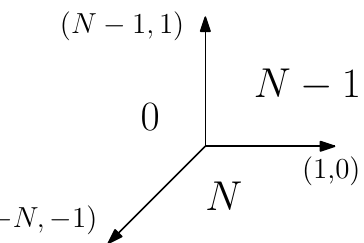
Figure 13. A con(cid:12)guration of branes corresponding to the coset U( N ) (cid:20) = U( N (cid:0) 1) (cid:20) . The level is encoded in (cid:9) = (cid:20)